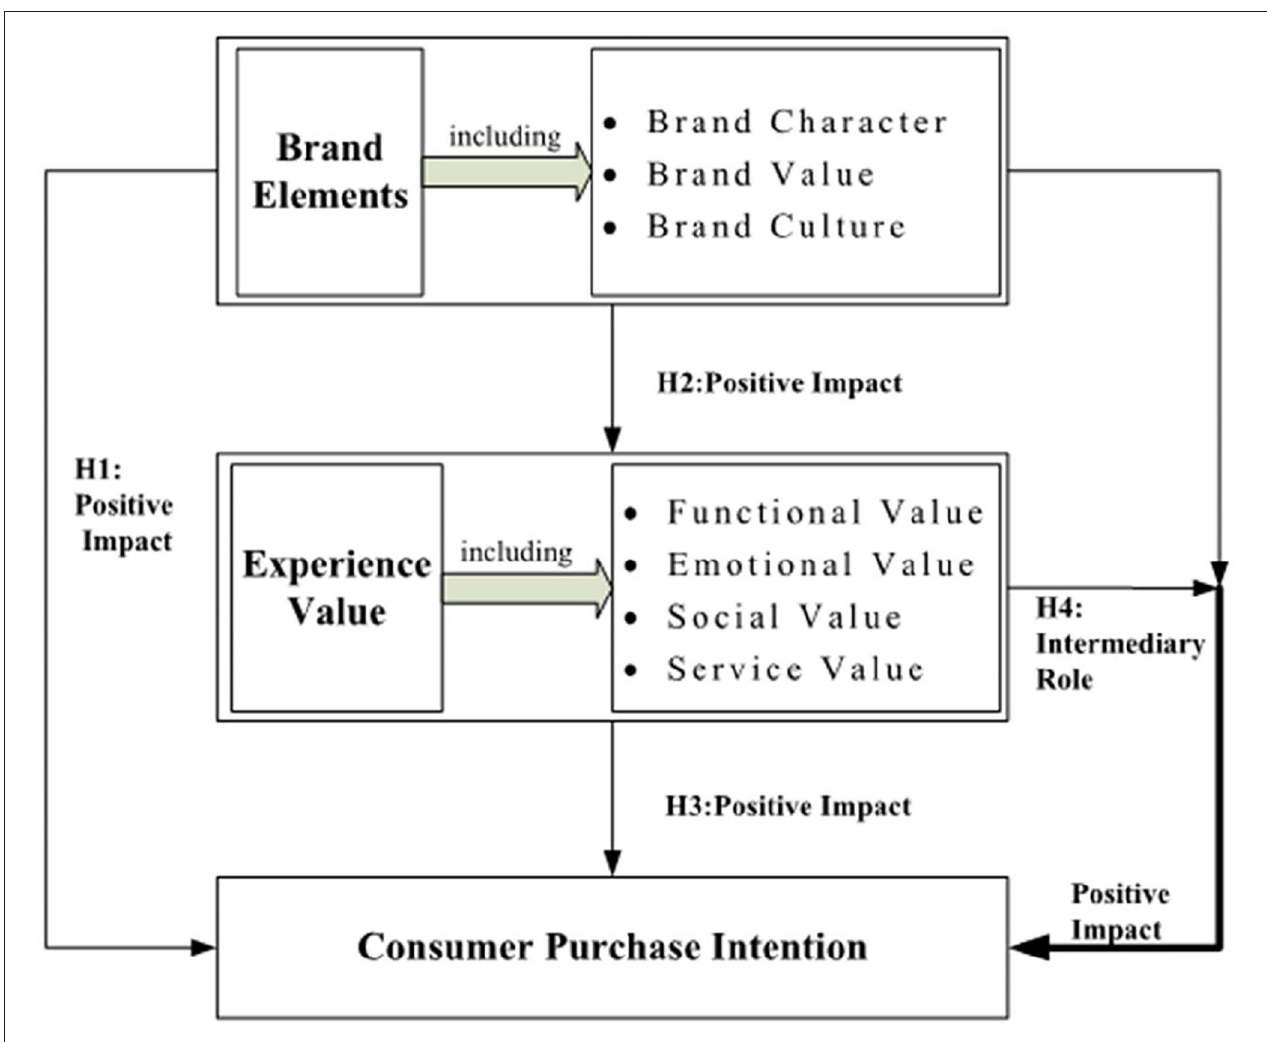
FIGURE 1 | Model of theoretical